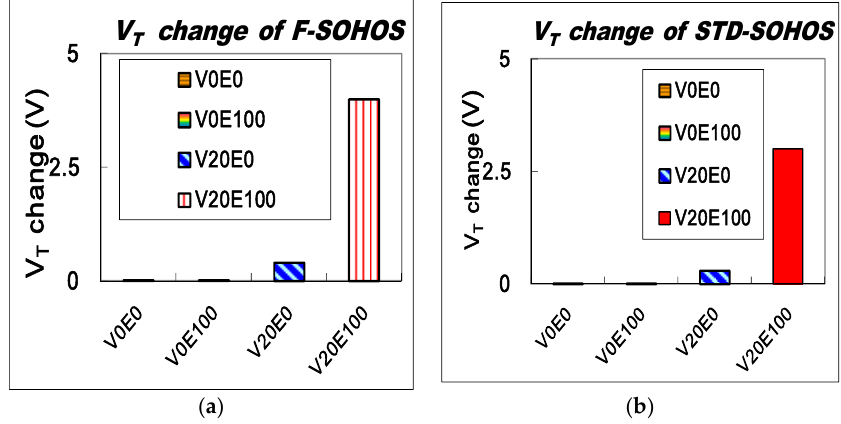
Figure 4. ( a ) The V T change of F-SOHOS capacitor devices after various UV irradiation; ( b ) The V T change of STD-SOHOS capacitor devices after various UV irradiation.